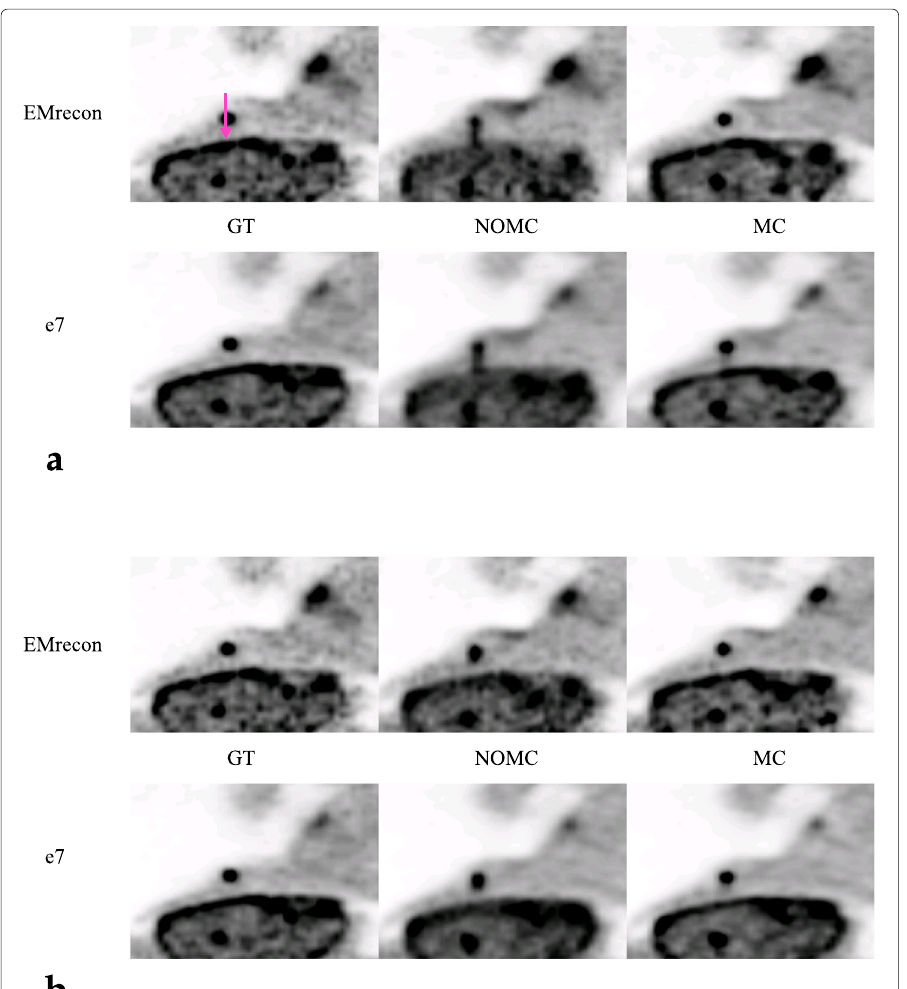
Fig. 4 Thorax phantom experiments with different motion amplitudes ( a 2 cm, b 1 cm) showing GT results in comparison to NOMC and MC (coronal